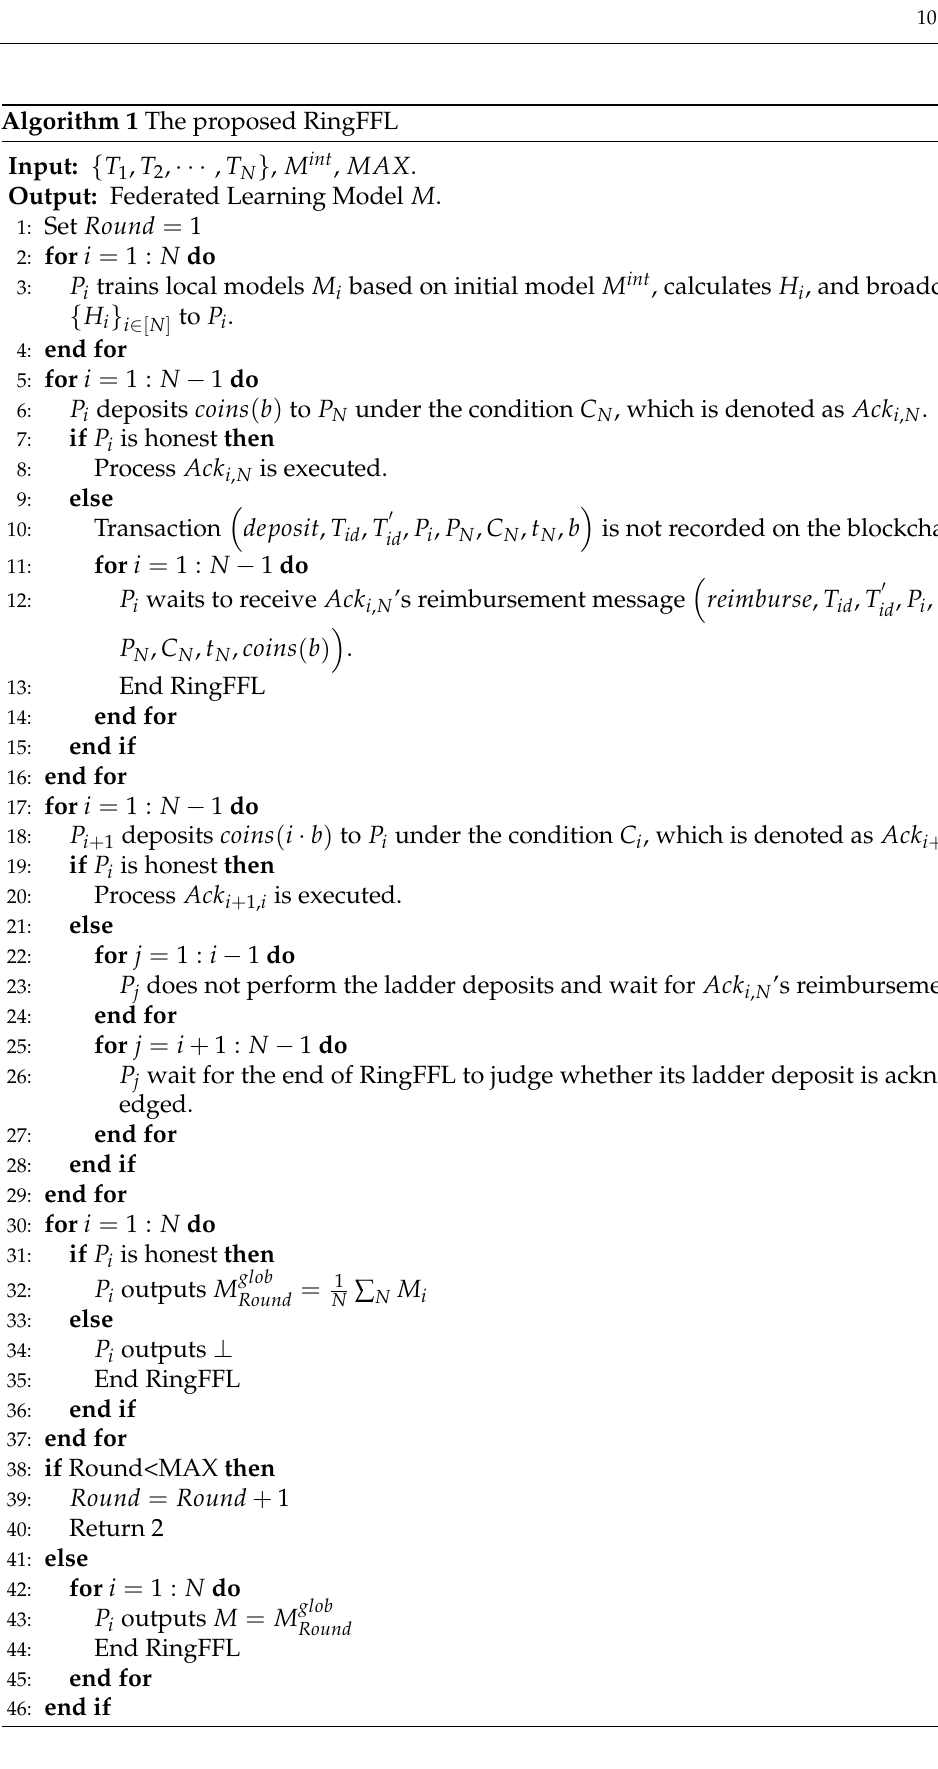
Algorithm 1 The proposed